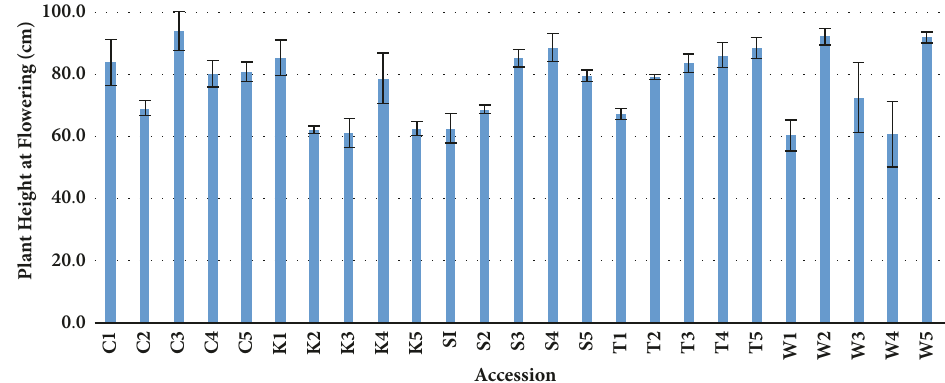
Figure 1: Plant height of sesame accessions collected from some districts in northern Ghana. Error bars represent standard error of